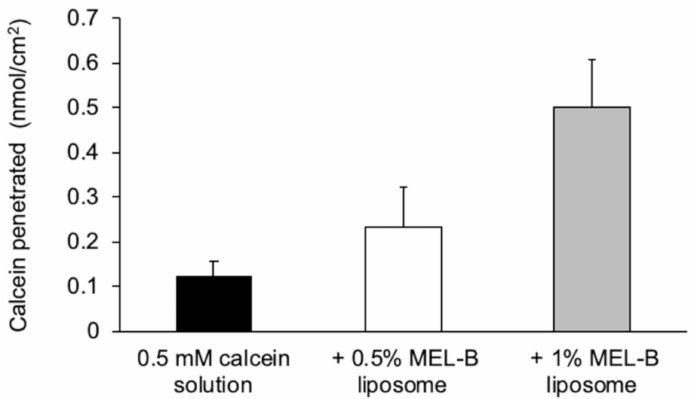
Figure 5. Skin permeation of calcein through hairless mouse skin after the application of calcein aqueous solution or MEL-B liposomes containing calcein. Symbols: closed bar, 0.5 mM calcein aqueous solution; open bar, 0.5 mM calcein aqueous solution + 0.5% MEL-B liposomes; gray bar, 0.5 mM calcein aqueous solution + 1.0% MEL-B liposomes. Values are expressed as the mean ± S.D. of three experiments.